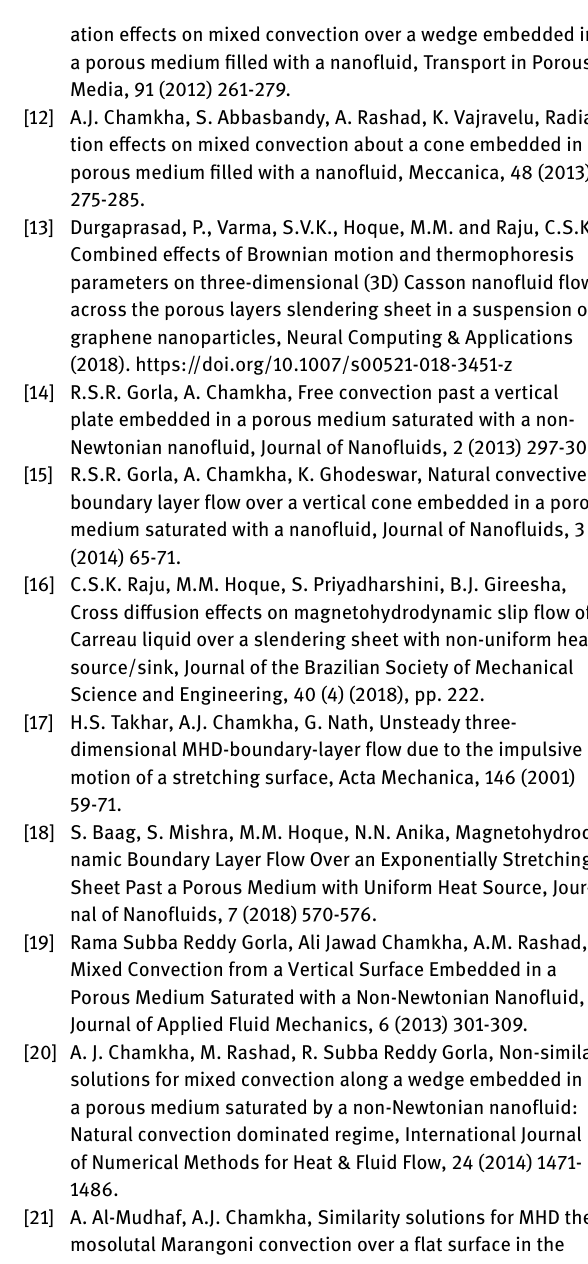
a porous medium filled with a nanofluid, Transport in Porous Media, 91 (2012)